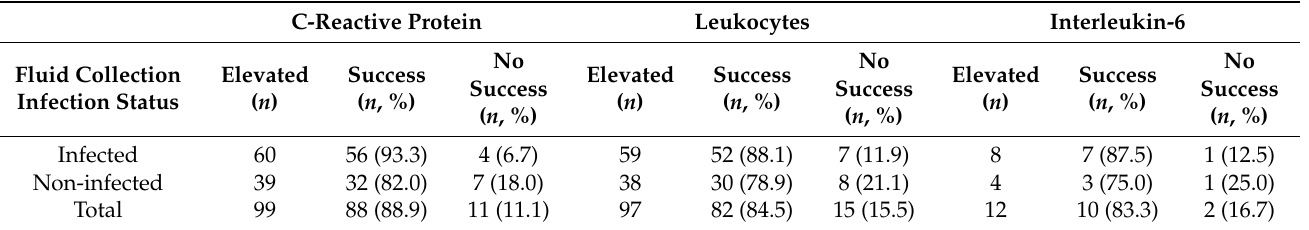
Table 6. Success rate distribution of decreasing laboratory parameters between infected and non- infected fluid